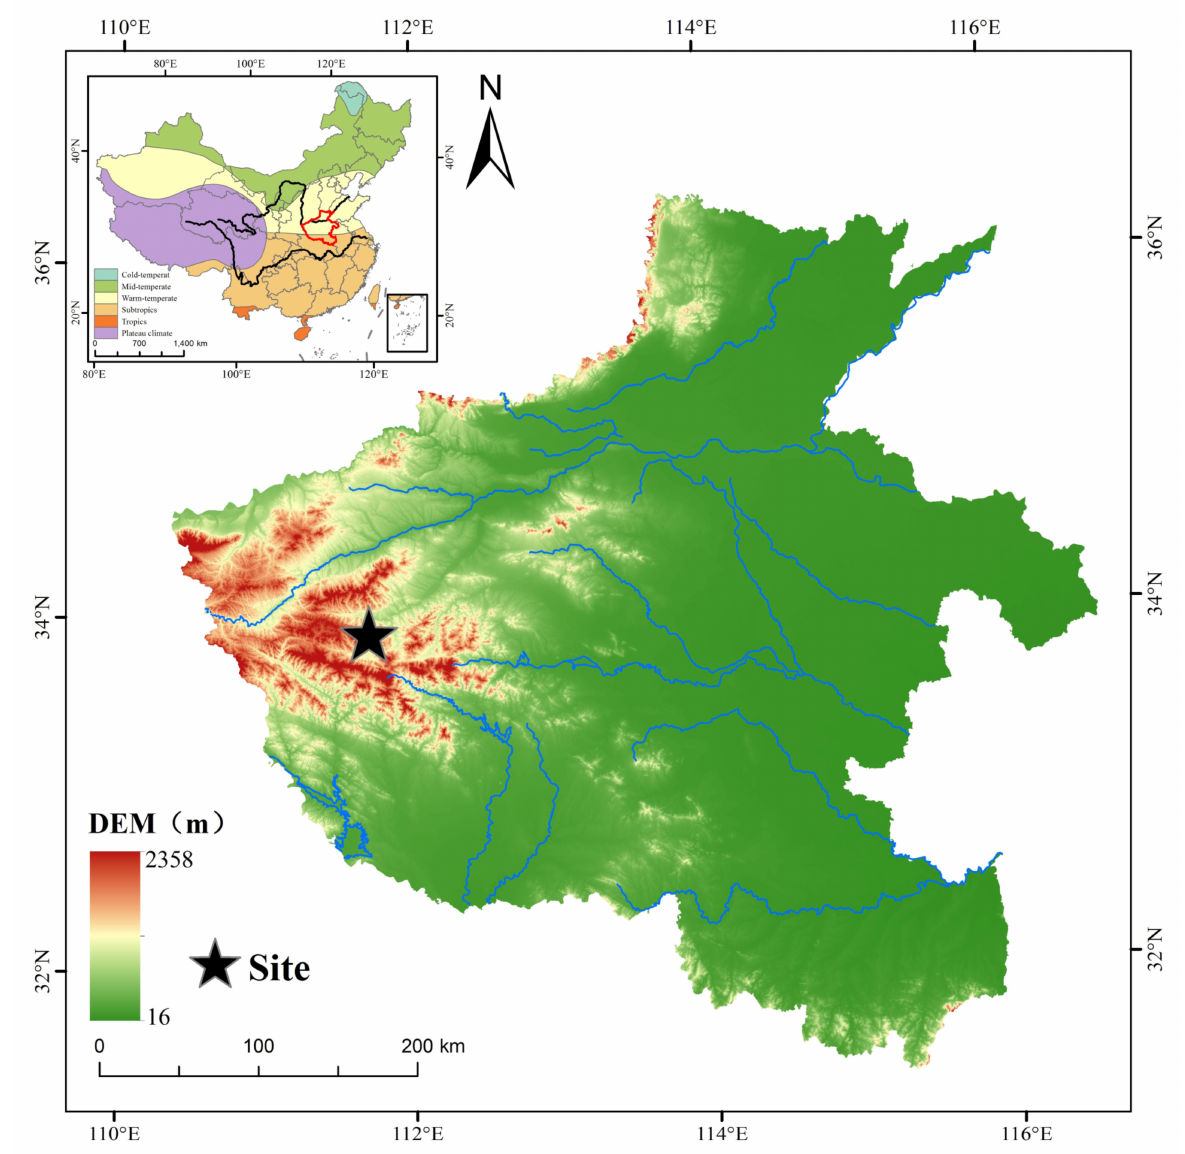
Figure 1. Location of different disturbance dynamics plots in the temperate − subtropical ecological transition zone of the Baiyun Mountain Nature Reserve. DEM represents